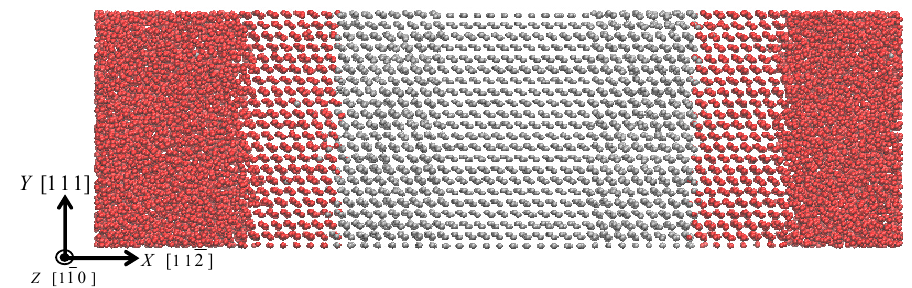
Figure 5. A snapshot of the <112> growth with a tensile strain of 0.02, at 700 ps.